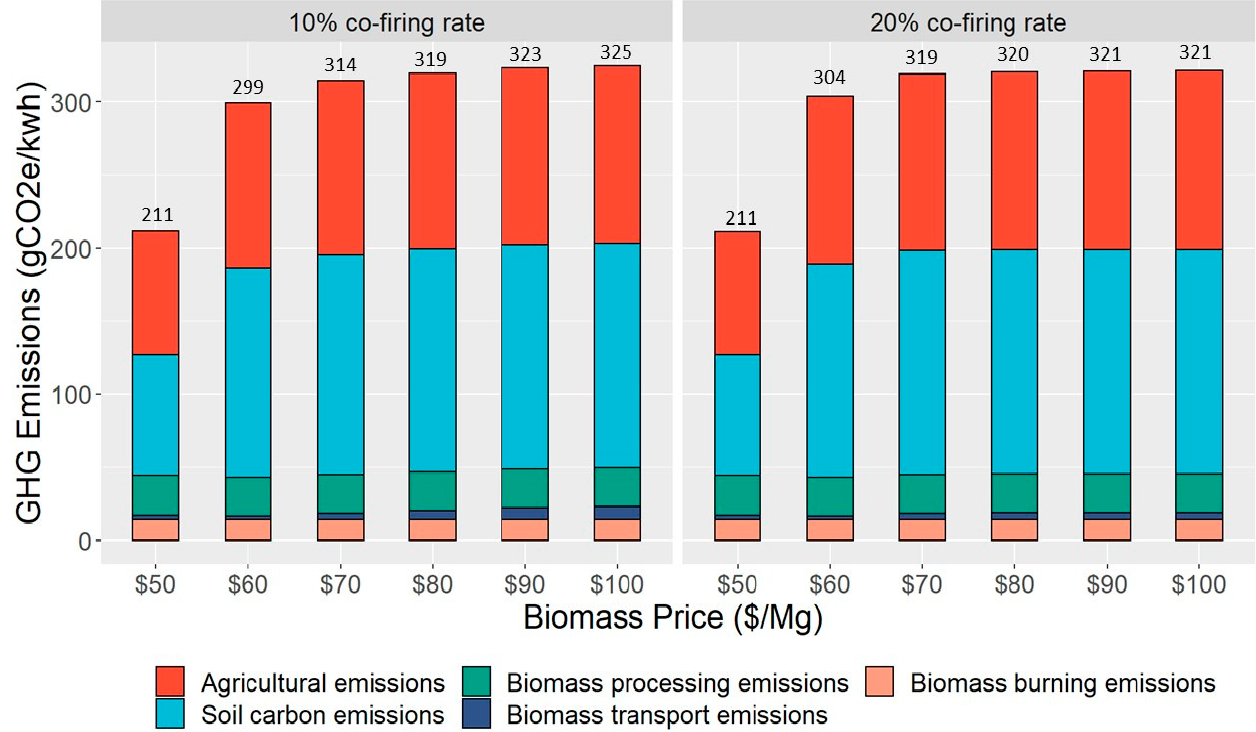
Figure 6. GHG emissions of biopower generation by